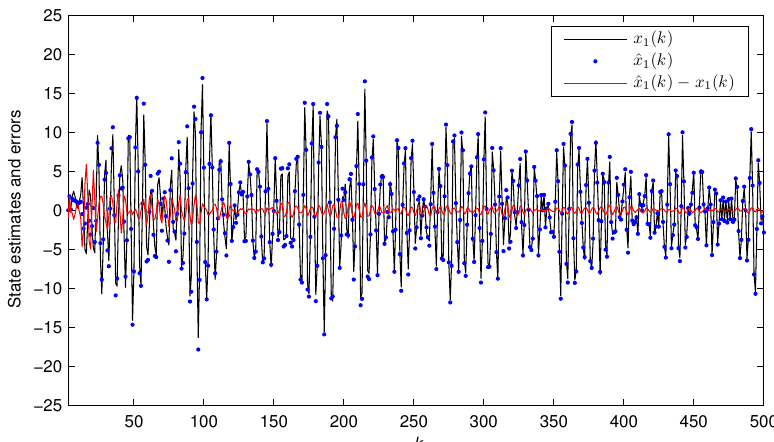
Figure 3. The state x 1 ( k ) and the estimated state ˆ x 1 ( k ) versus k for Example 1 ( δ = 0.25).